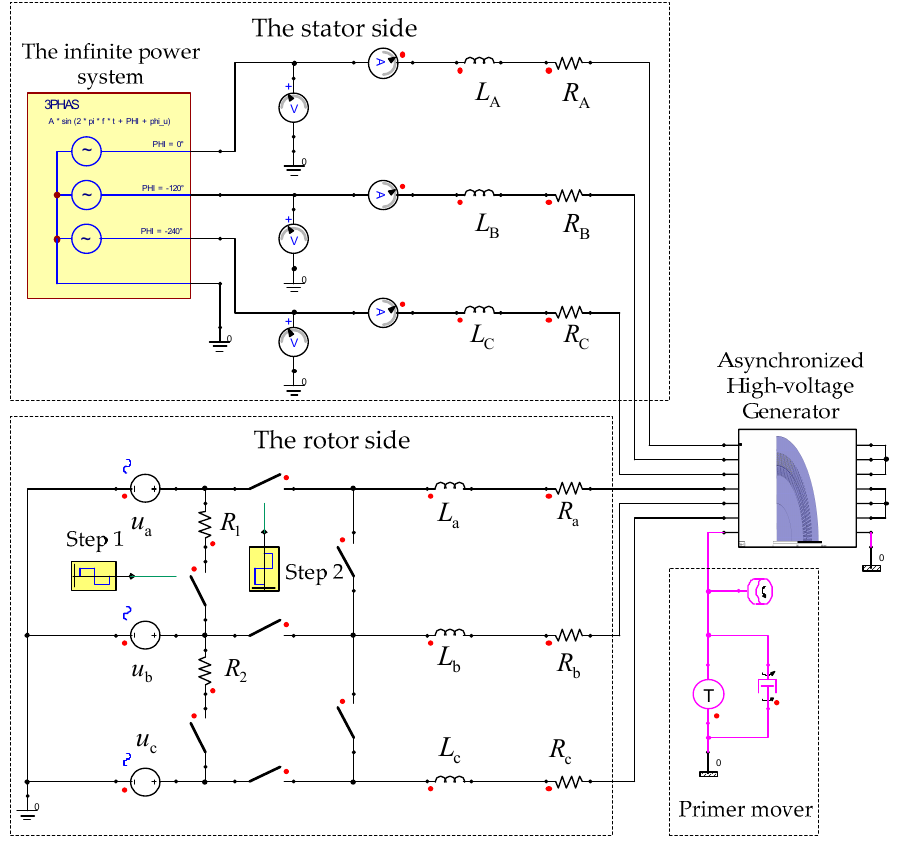
Figure 5. The simulation model of the asynchronized high-voltage generator under a loss of excitation.